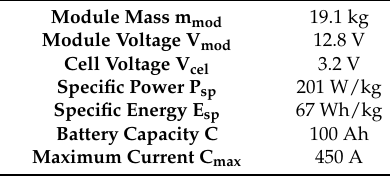
Table 6. LiFePO 4 Specifications